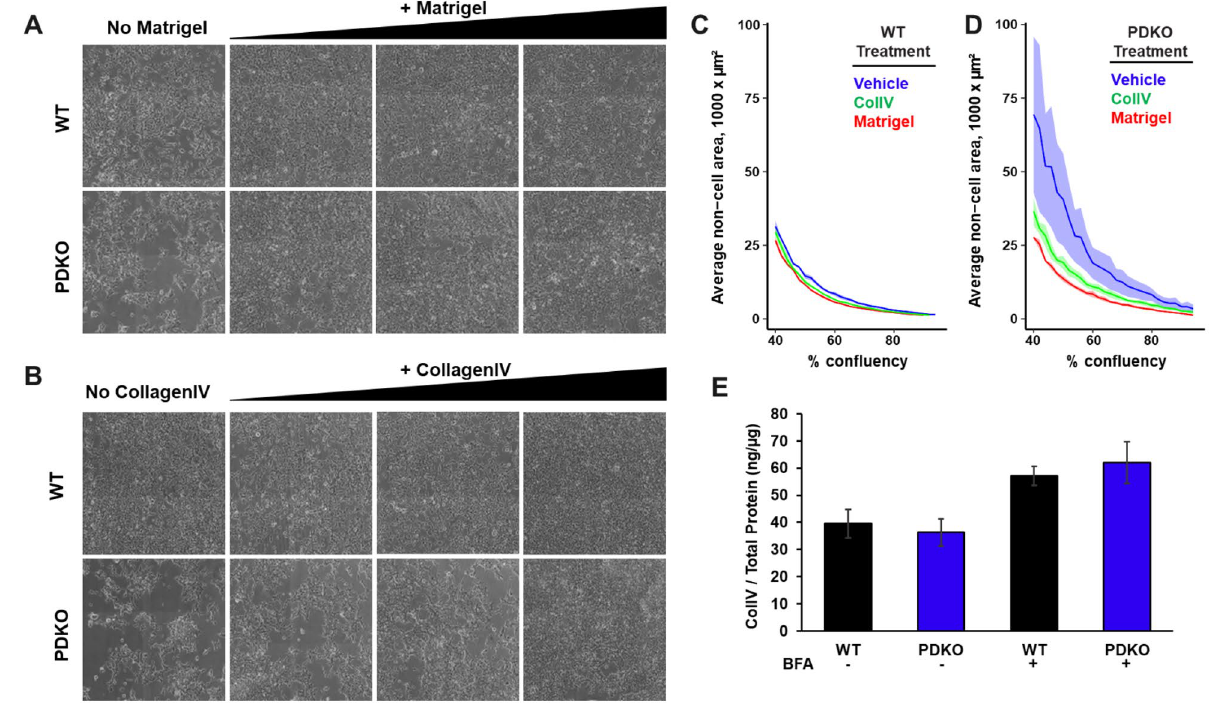
Figure 5. Extracellular matrix deposition relieves cellular aggregation. ( A ) WT and PDKO T-REx-293 cells were grown for 100 h with varying dilutions of Matrigel, ranging from 1/100 to 1/20. ( B ) WT and PDKO T-REx-293 cells were grown for 100 h with varying dilutions of ColIV, ranging from 1 to 10 µg per cm 2 of growth area. ( C ) Quantification of data visualized in ( A ) and ( B ) for WT T-REx-293 cells grown on vehicle (blue), CollagenIV (green), and Matrigel (red). Shaded regions represent standard error of the mean. ( D ) Quantification of data visualized in ( A ) and ( B ) for PDKO T-REx-293 cells grown on vehicle (blue), CollagenIV (green), and Matrigel (red). Shaded regions represent standard error of the mean. ( E ) ELISA quantification of ColIV protein compared to total protein in WT and PDKO T-REx-293 cells with and without the addition of BFA. Measurements were calculated using 3–5 biological replicates. Error bars represent standard